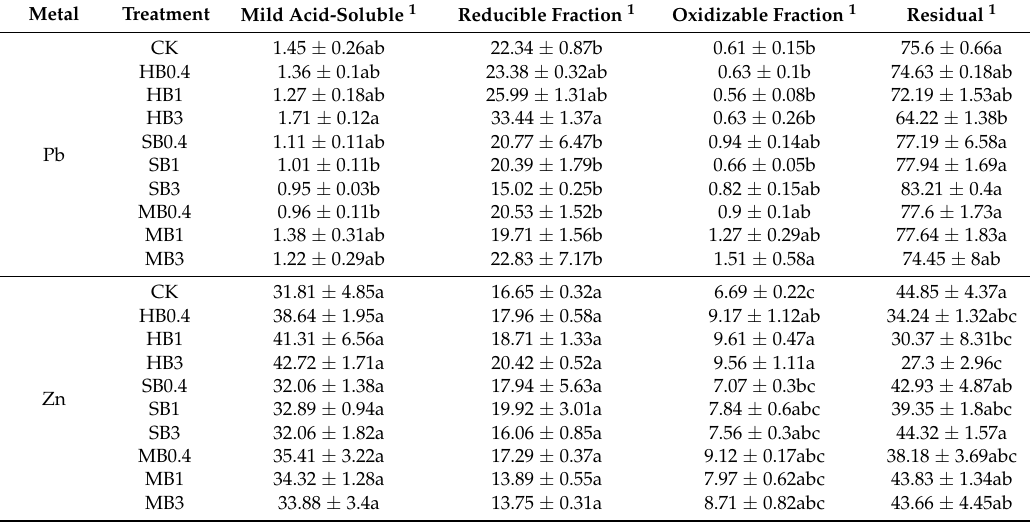
Table 5. Effects of HB, SB and MB treatments on chemical fractionation of metal in mine tailings